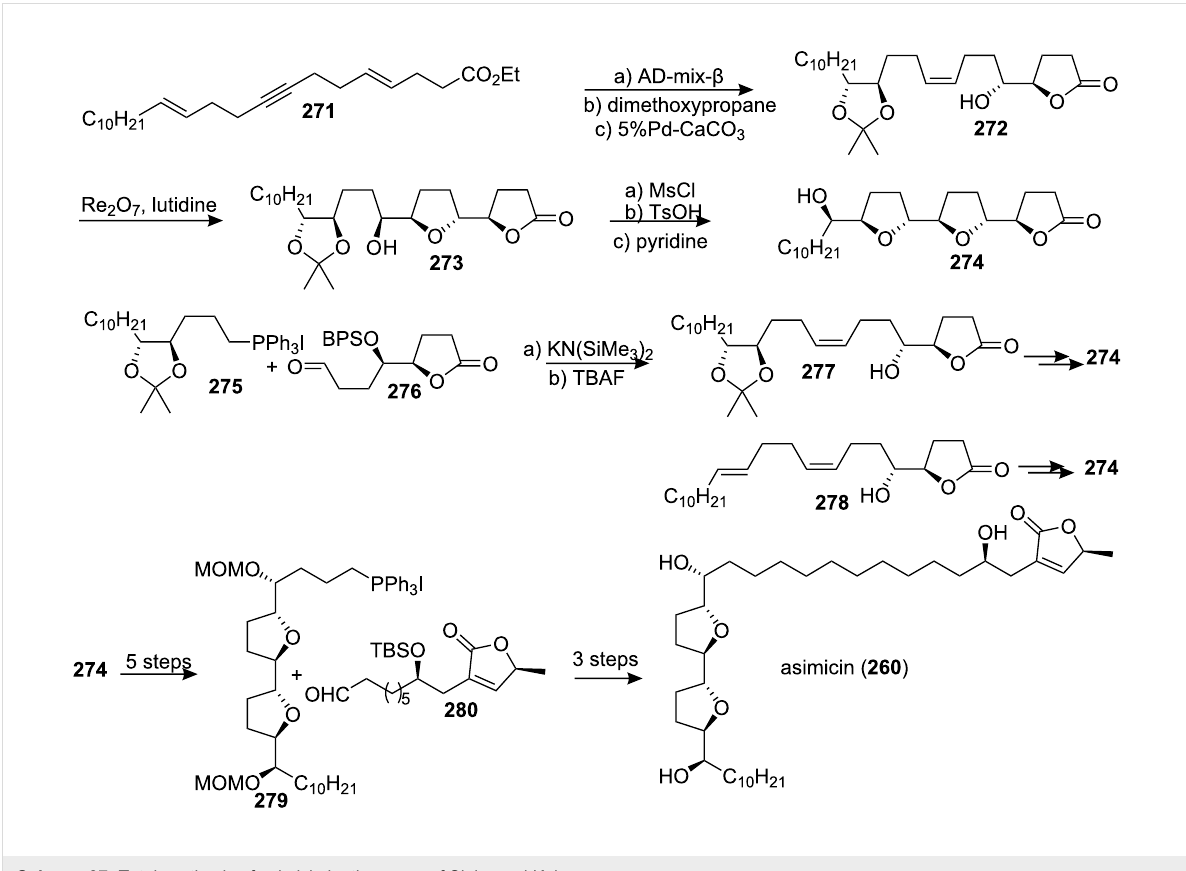
Scheme 37: Total synthesis of asimicin by the group of Sinha and